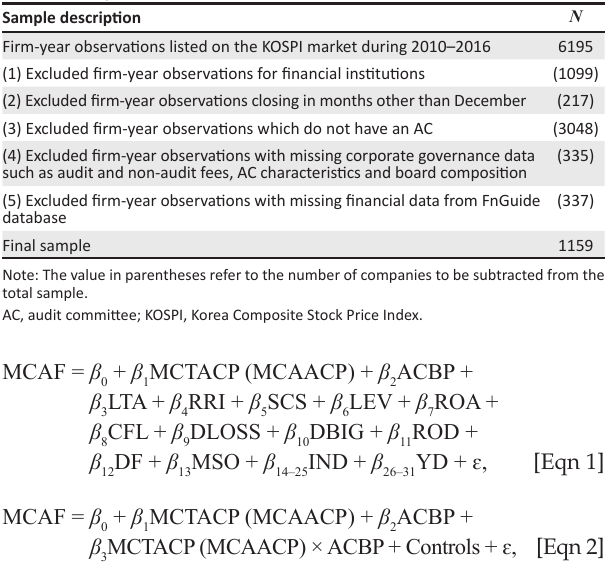
TABLE 1: Sample selection. Sample description N Firm-year observations listed on the KOSPI market during